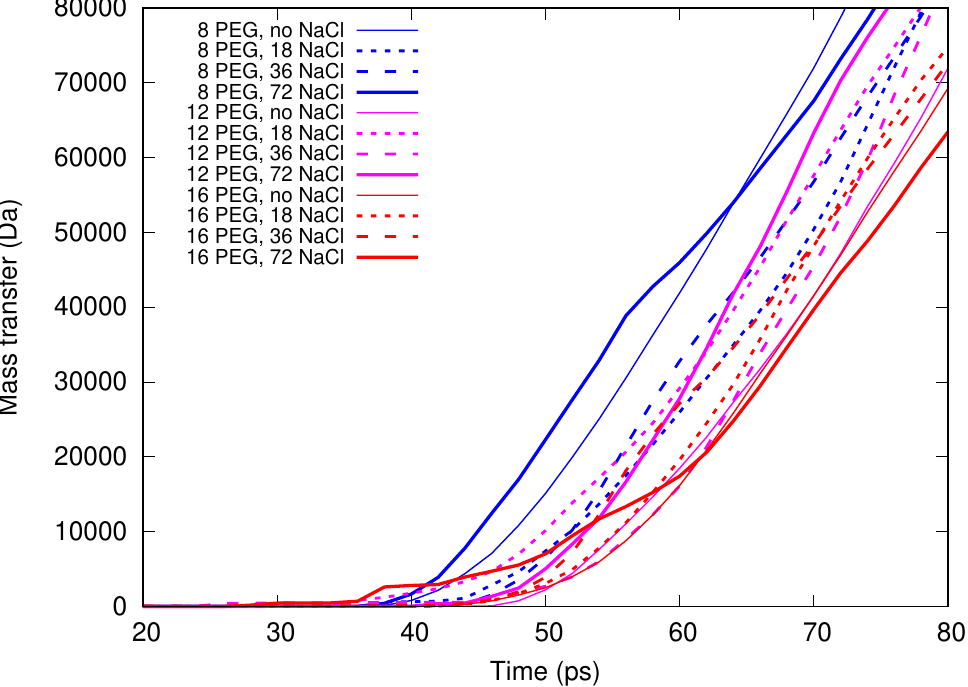
Figure 10. Mass transported through the plane at z = 20 nm as a function of production time for samples with 5.26-kDa PEG chains under 1.5 V/nm. Curves correspond to different numbers of 5.26-kDa PEG chains and NaCl ion pairs, see the legend. Plotted with gnuplot [56].